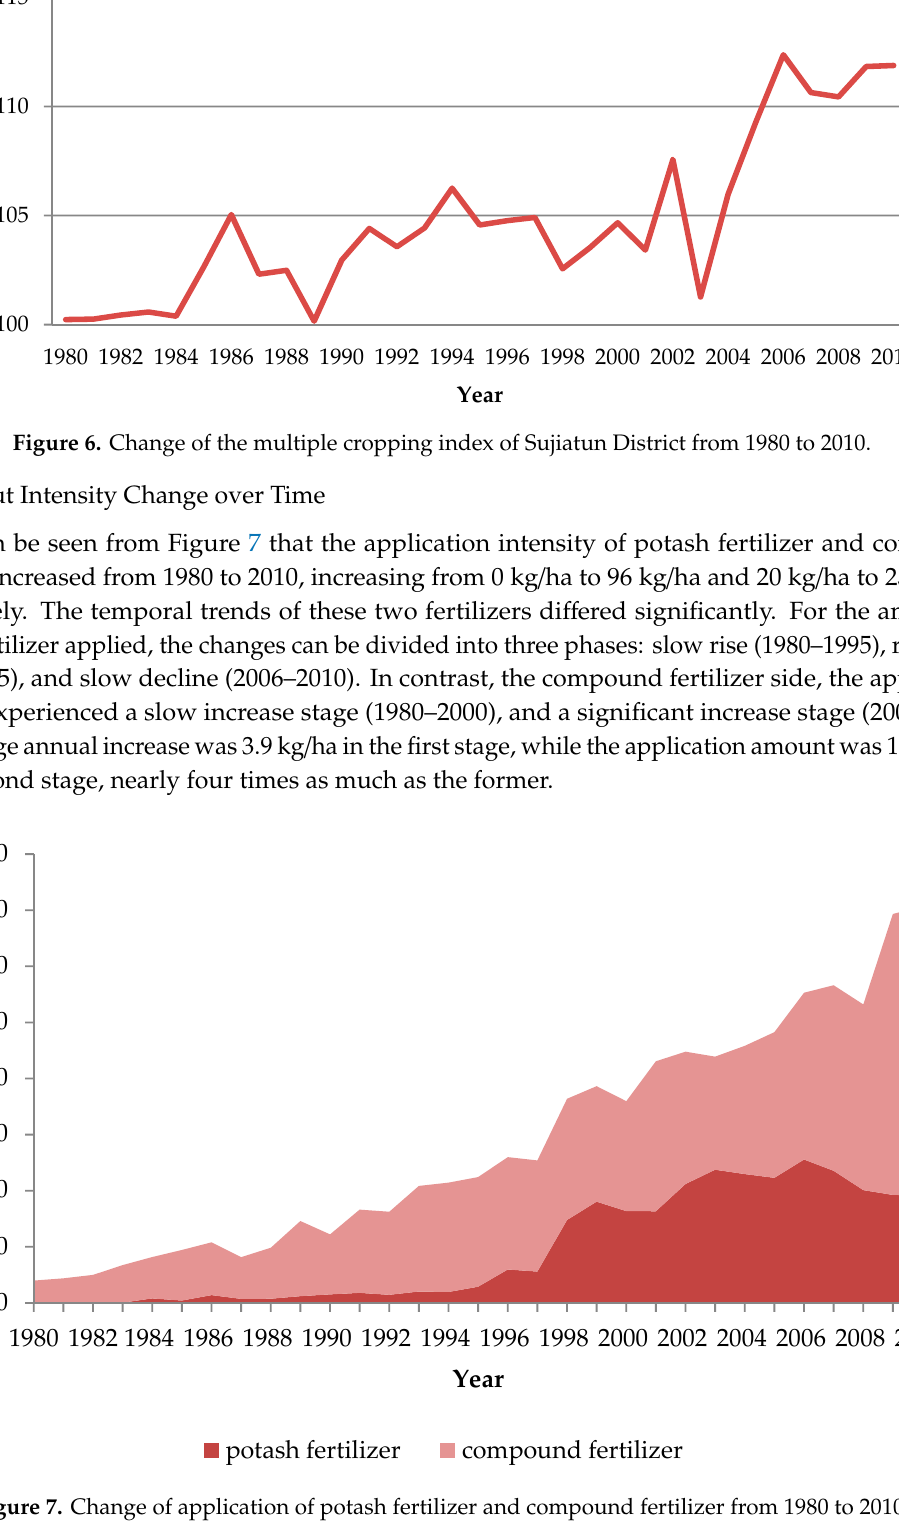
Figure 7. Change of application of potash fertilizer and compound fertilizer from 1980 to 2010.